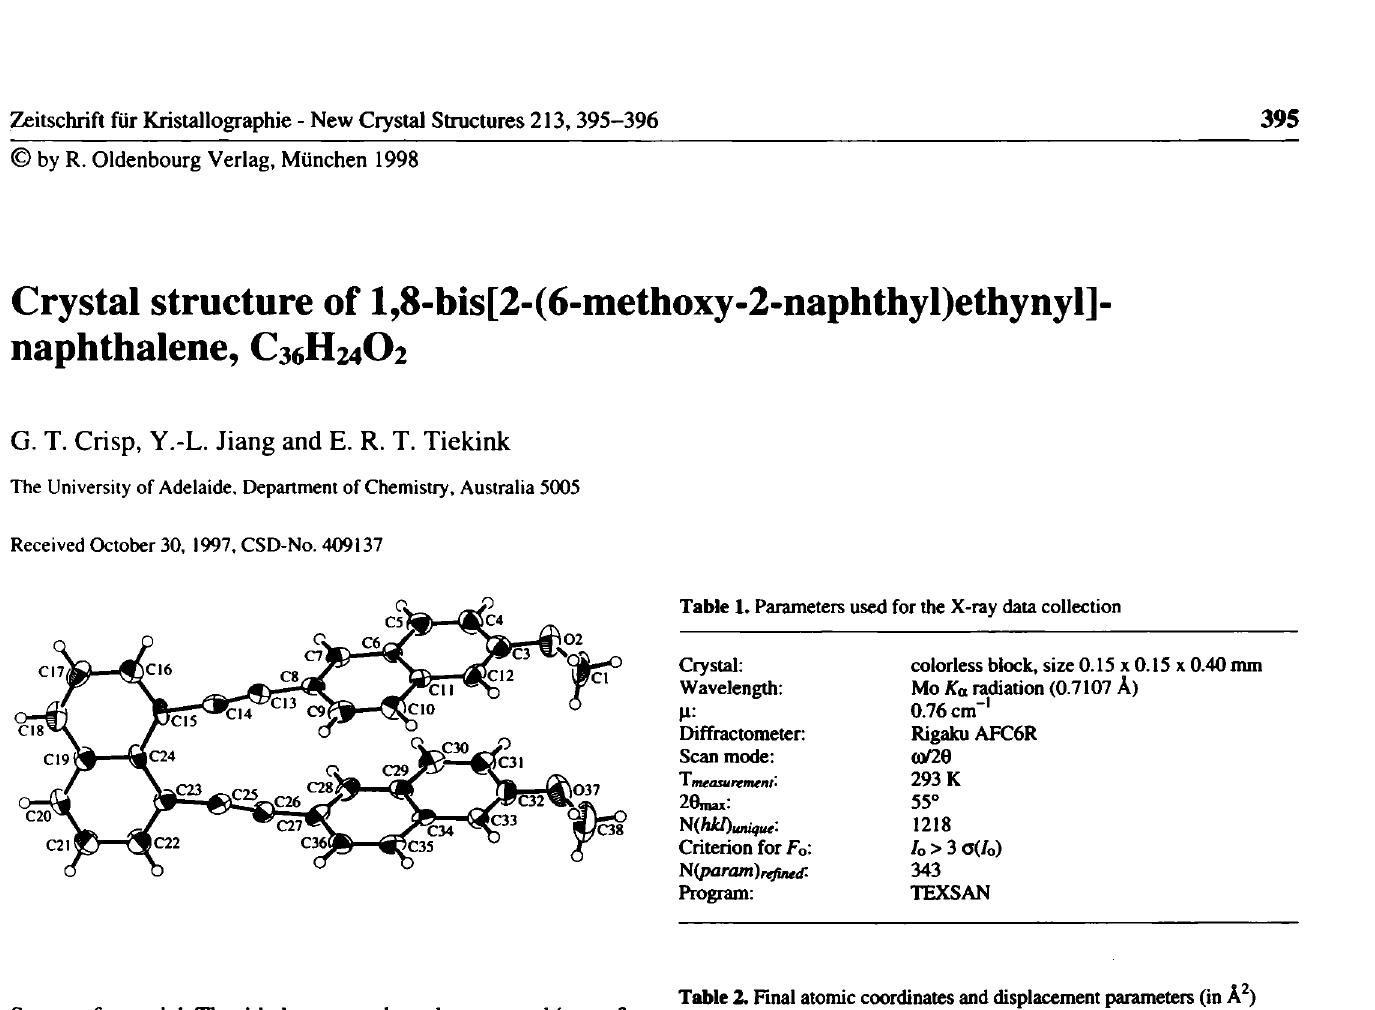
Table 2. Final atomic coordinates and displacement parameters (in A^)